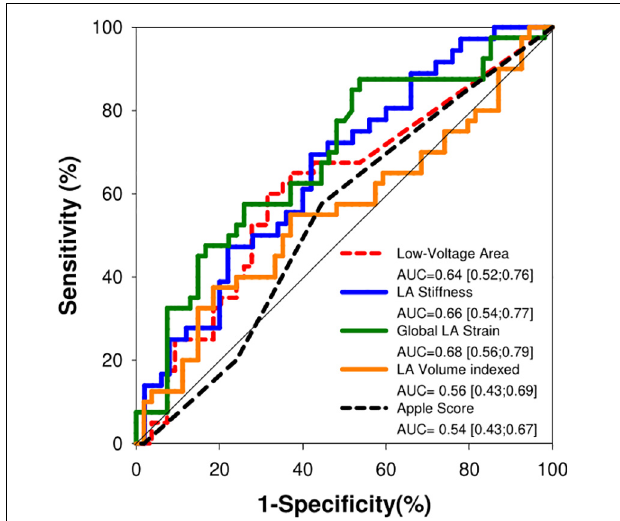
FIGURE 4 | Receiver-operating characteristic curve analysis for prediction of atrial fibrillation recurrence after catheter ablation. AUC, area under the curve; p = 0.02 GPALS vs. Apple score and p = 0.05 GPALS vs. LAVI.